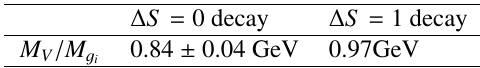
Table 1. Input parameters used for Q 2